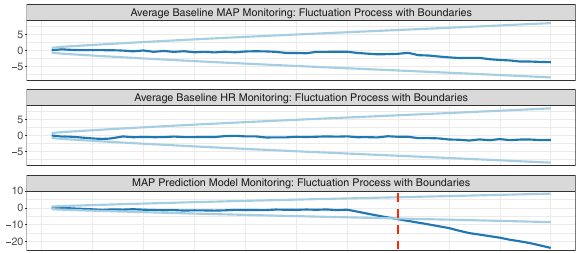
Fig. 3 Continual monitoring of a hypothetical AI algorithm for forecasting mean arterial pressure (MAP). Consider a hypothetical MAP prediction algorithm that predicts a patient ’ s risk of developing an acute hypotensive episode based on two input variables: baseline MAP and heart rate (HR). The top two rows monitors changes in the two input variables using the CUSUM procedure, where the dark line is the chart statistic and the light lines are the control limits. The third row aims to detect changes in the conditional relationship between the outcome and input variables by monitoring the residuals using the CUSUM procedure. An alarm is fi red when a chart statistic exceeds its control limits.